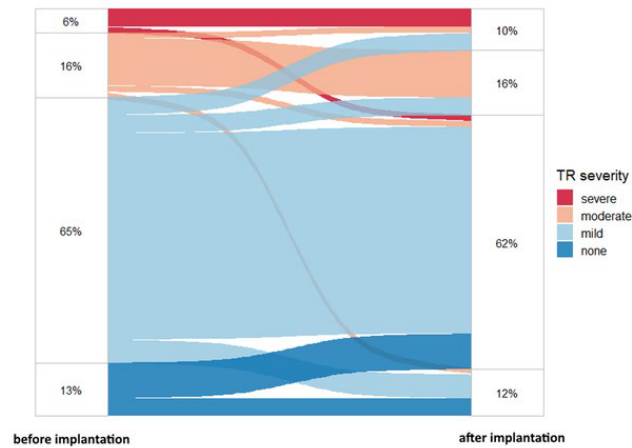
Fig. 1: Alluvial diagram of TR severity before and after LLPM implantation.